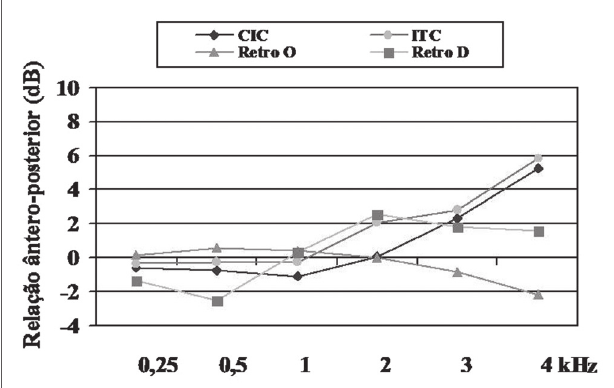
Gráfico 1. Valores médios da relação ântero-posterior, nas frequências de 250 a 4000Hz (n=34).